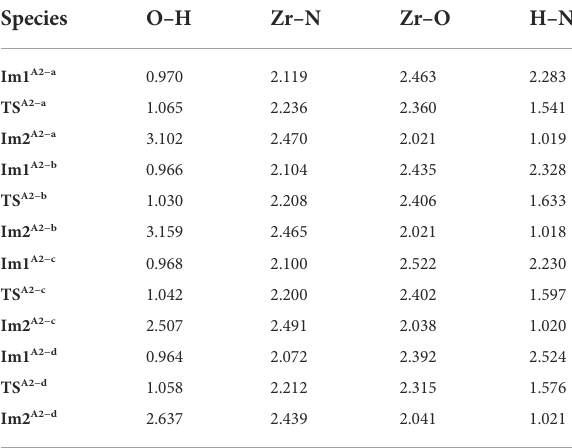
TABLE 2 Bond lengths (Å) at the reaction center in the A2 section of the TDMAZ reaction on the hydroxylated surface.